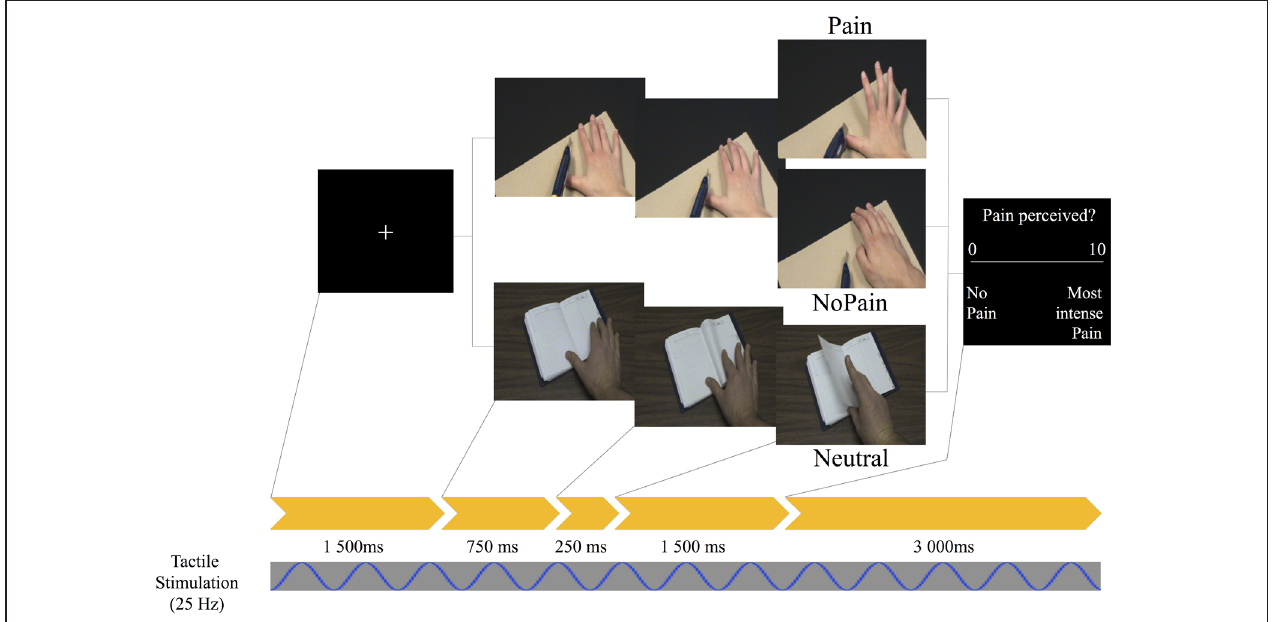
FIGURE 1 | Schematic of the experimental design depicting one trial. Timing in ms (below yellow arrows) corresponds to the duration of each picture. A light repetitive stimulation at a frequency of 25Hz was continuously applied to the palm of the right hand throughout data acquisition.